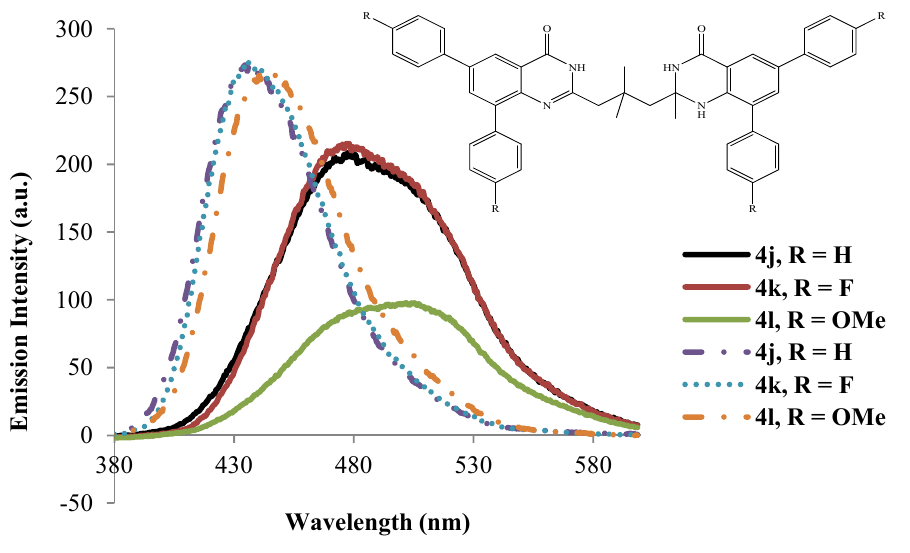
Figure 9. Emission spectra of 4j – l ( λ (solid lines) at rt (conc. = 1.0 × 10 − 4